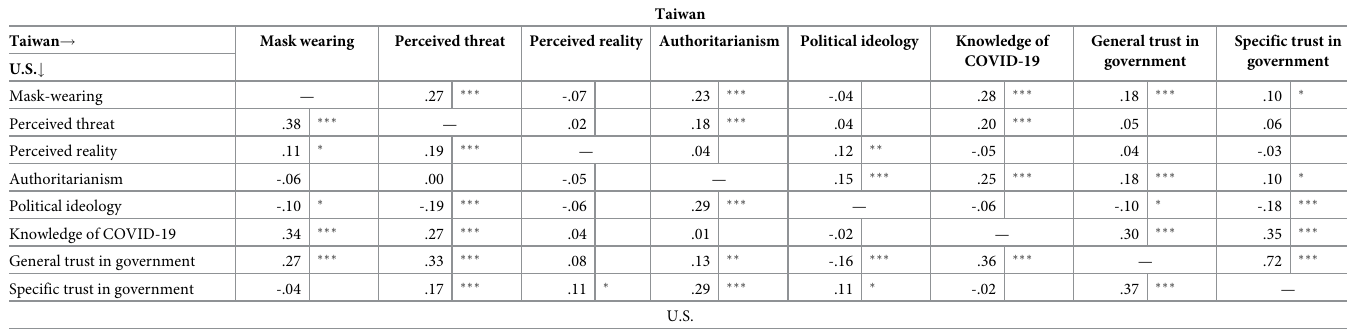
Table 4. Bivariate correlations among key